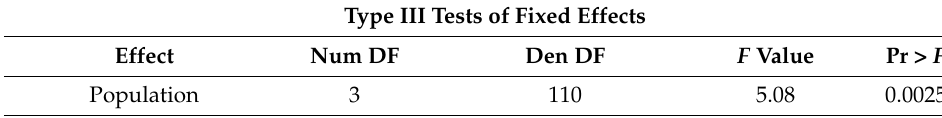
Table A12. 2020 Four Population Seed Mass.